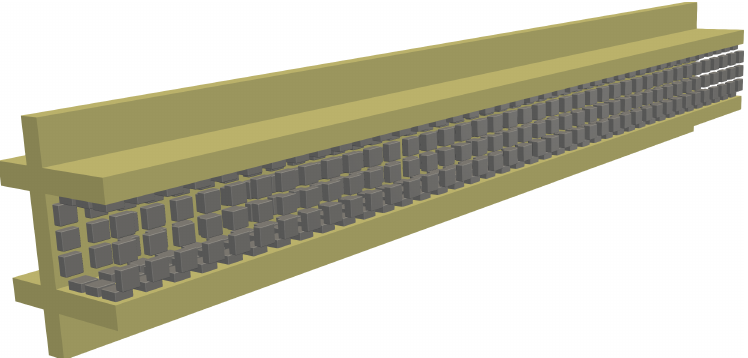
Figure 4. Channel model with uniformly fragmented PM layer in gray. Dark yellow structures represent porous filter substrate.